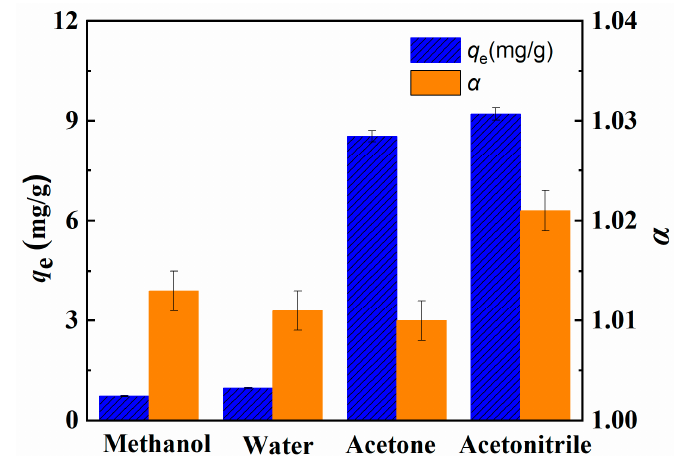
Figure 6. Effect of solvent on the adsorption uptake of Li + and separation factor of isotopes by MCM- g -AB15C5 (adsorption condition: CF 3 COOLi, [Li + ] = 1 g ⋅ L –1 , 25 °C).